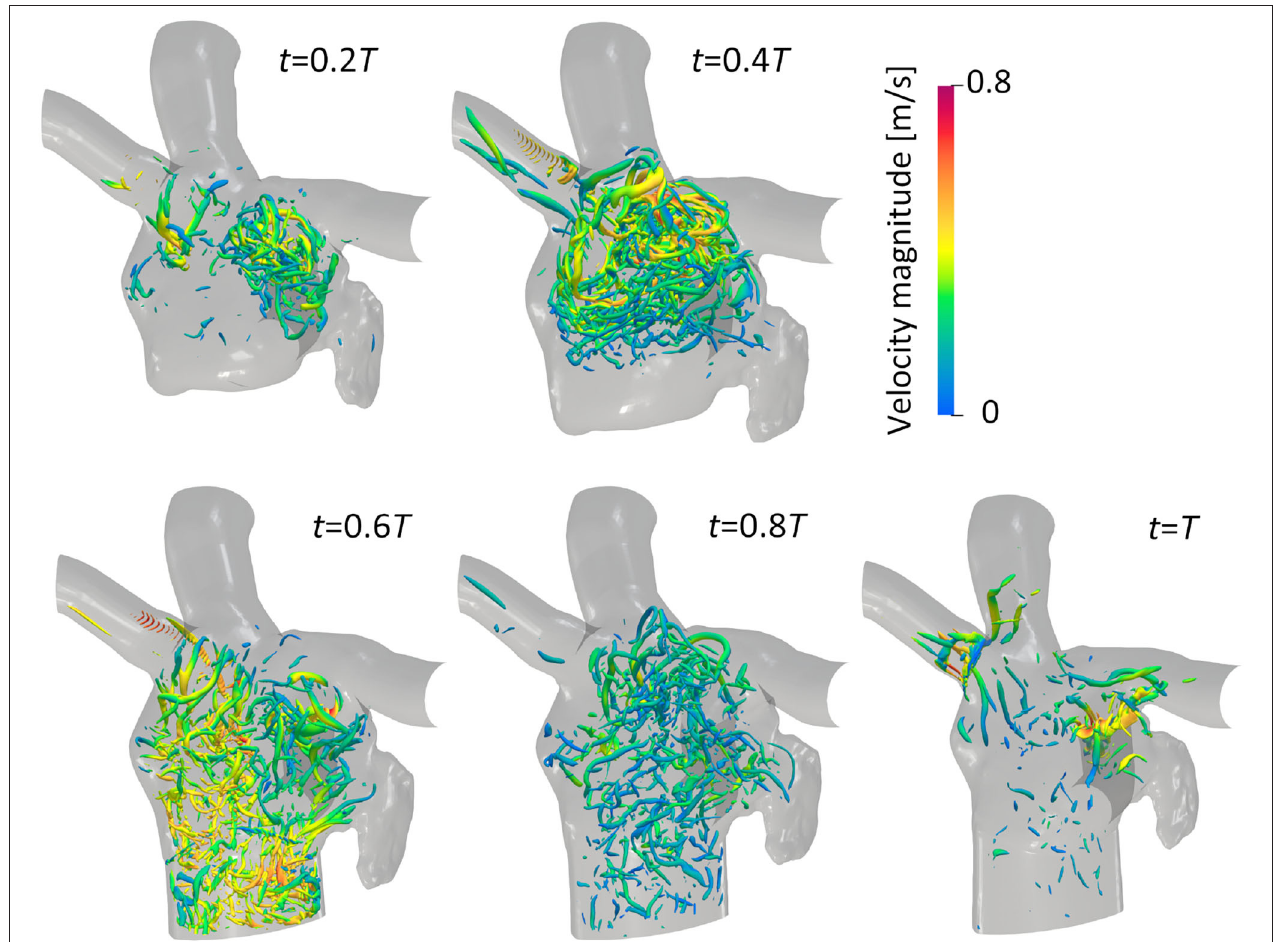
FIGURE 5 | Anterior views of vortex iso-surfaces identified using the λ 2 criterion ( λ 2 = − 0.01 ms 2 ) at t = 0.2 T , 0.4 T , 0.6 T , 0.8 T , and T before the left upper lobectomy ( T : cardiac cycle from the start of systole). Contour plots show the velocity